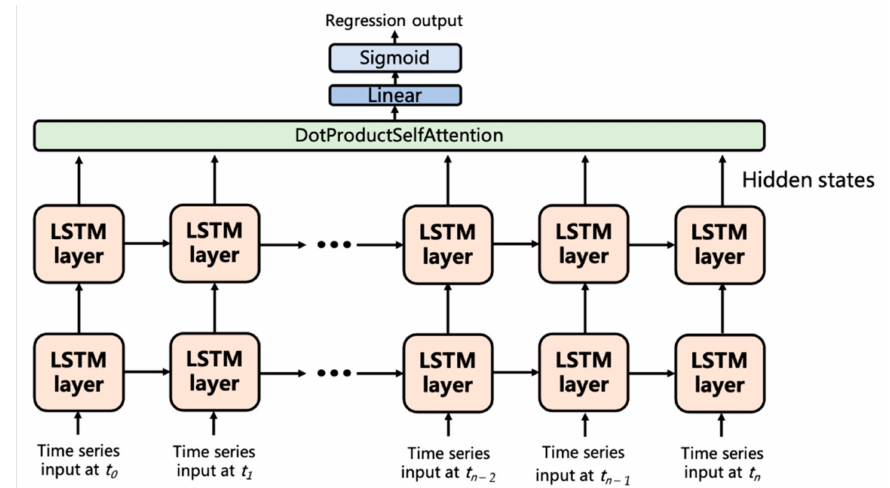
Figure 5. Model structure of the attention-enhanced LSTM.